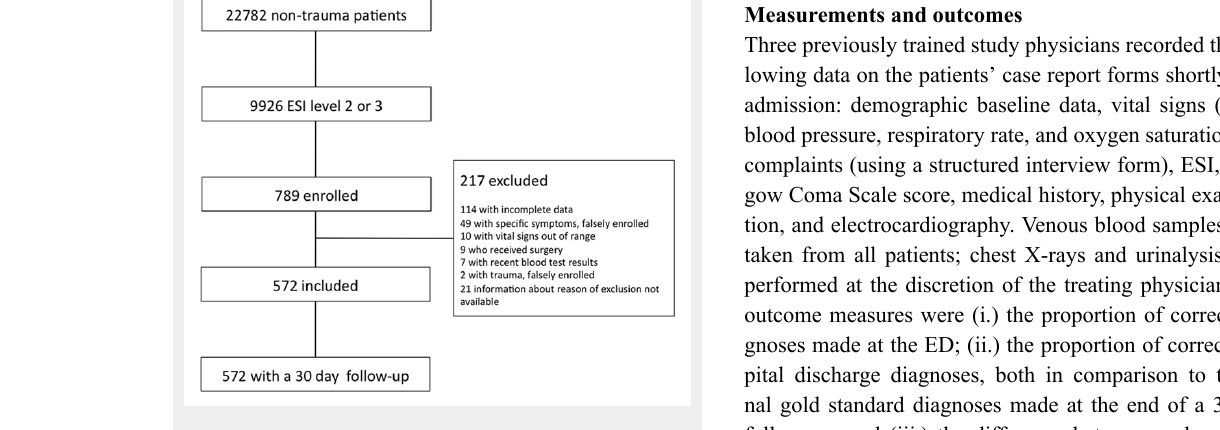
Overview of the enrolment of patients . ESI denotes emergency severity index (level 1: requires immediate life-saving intervention; level 2: high risk situation, confused, lethargic, disoriented, or severe pain/distress; level 3: two or more resources are needed;